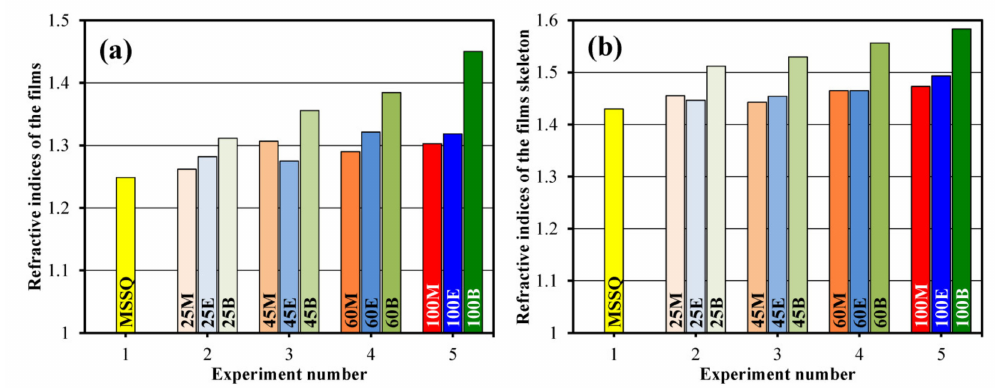
Figure 4. Refractive indices of the studied films ( a ) and their skeleton ( b ). The column termed as Experiment 1 corresponds to the methylsilsesquioxane (MSSQ) film prepared from pure methyltrimethoxysilane (MTMS). The samples in Experiments 2, 3, 4 correspond to concentrations of bridging groups’ precursors equal to 25, 45 and 60 mol%, respectively. No MTMS was used in Experiment